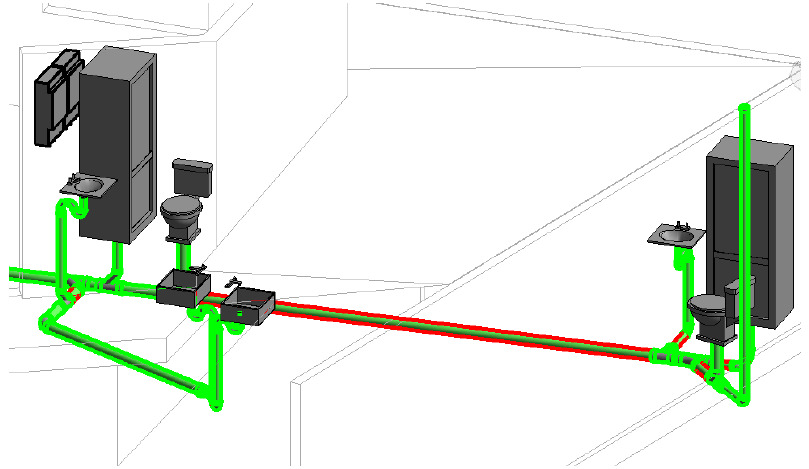
Figure 16. Example of an alert for pipelines that do not comply with the established minimum.